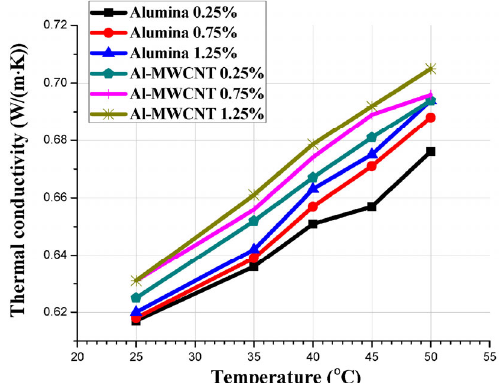
Fig. 7 Contact angle for alumina and Al-MWCNT hybrid nanofluid samples at different concentrations.